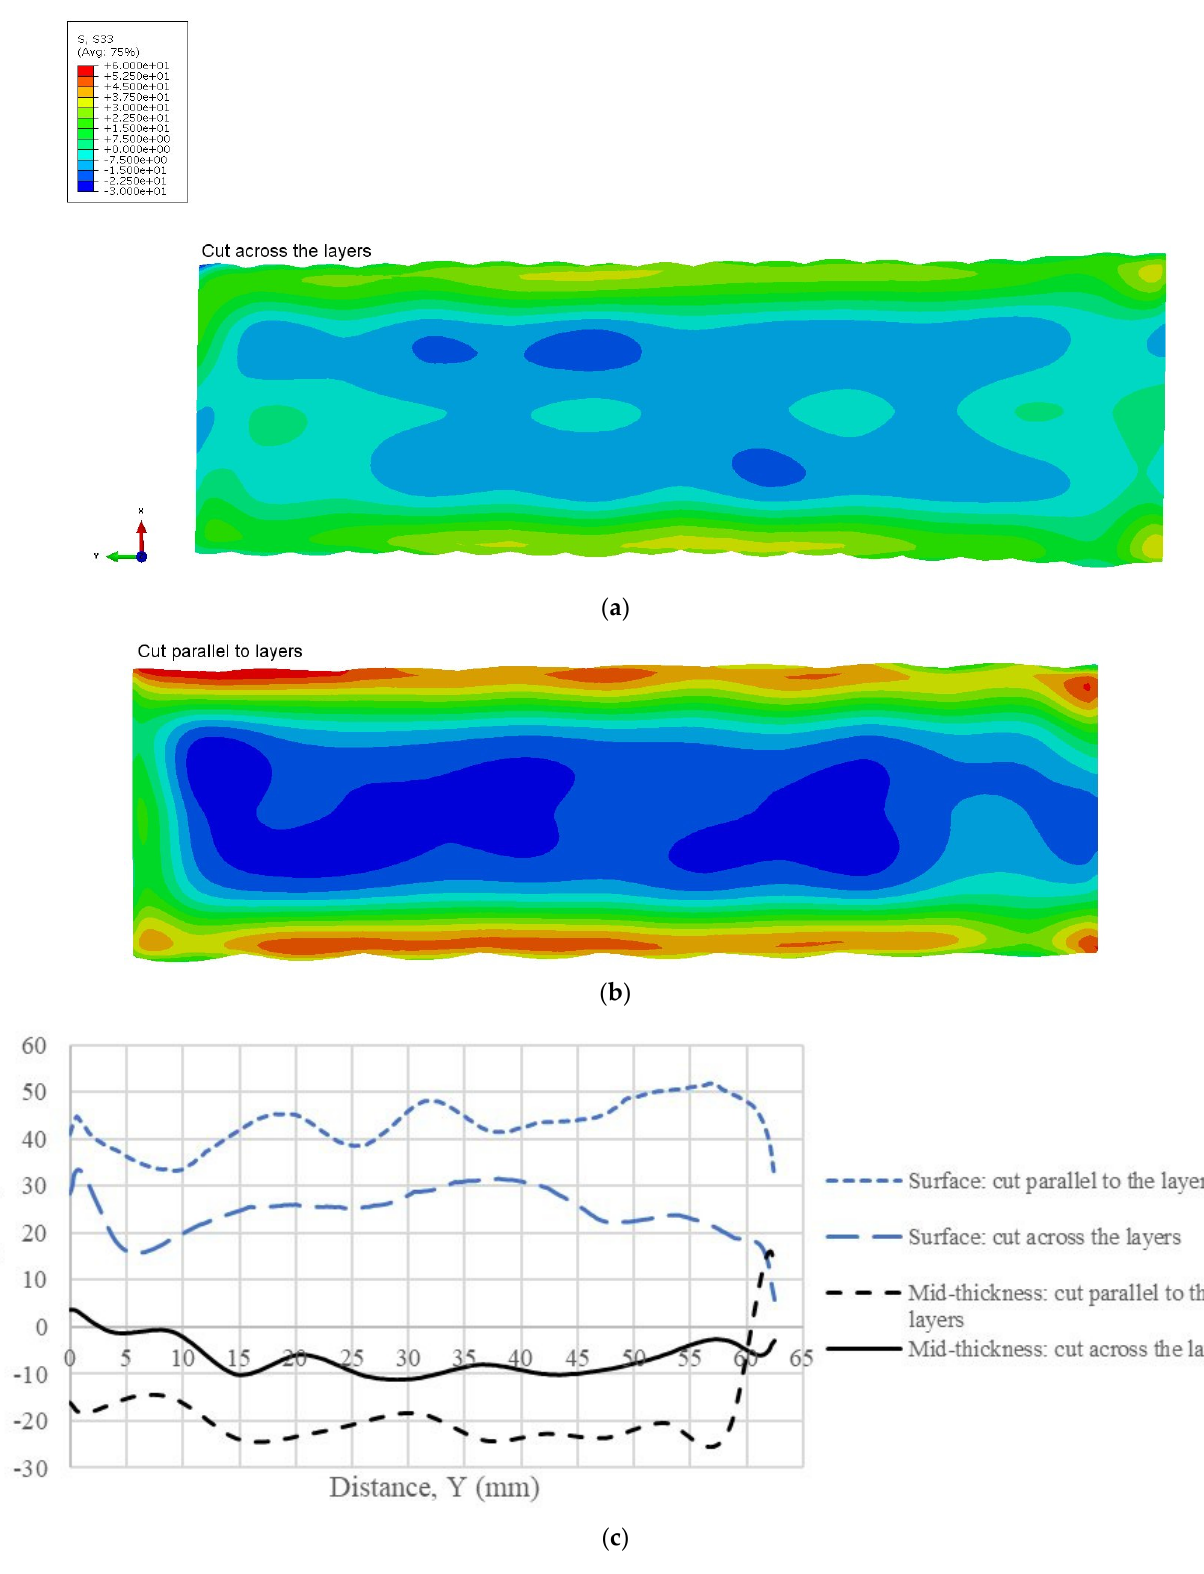
Figure 7. Residual stress in extracted small blocks from the oscillation path wall: ( a ) stress map for cut across the layers (62.5 mm × 20 mm), ( b ) stress map for cut parallel to layers (62.5 mm × 20 mm), ( c ) stress profiles . 3.5. Residual Stresses in Compact-Tension Coupons (Single Bead, Parallel Path and Oscillation Path)